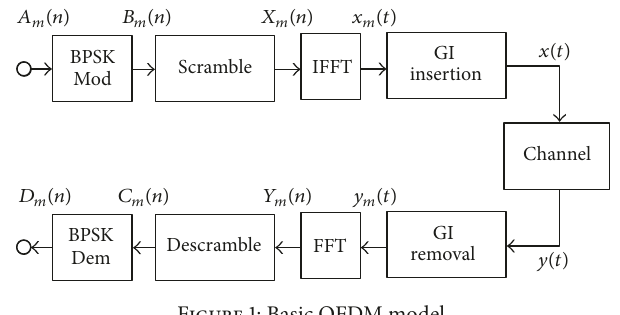
Figure 1: Basic OFDM model.